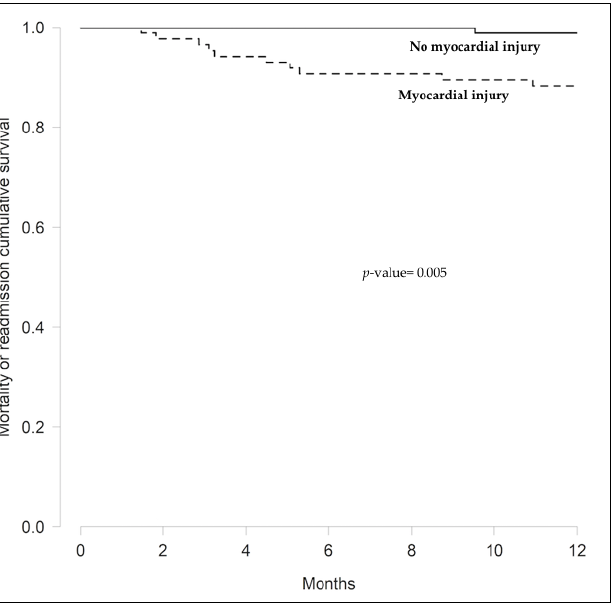
Figure 2. Kaplan–Meier curves for mortality and/or hospital readmission in 172 COVID-19 survivors according to the presence or absence of myocardial injury on initial hospital admission.